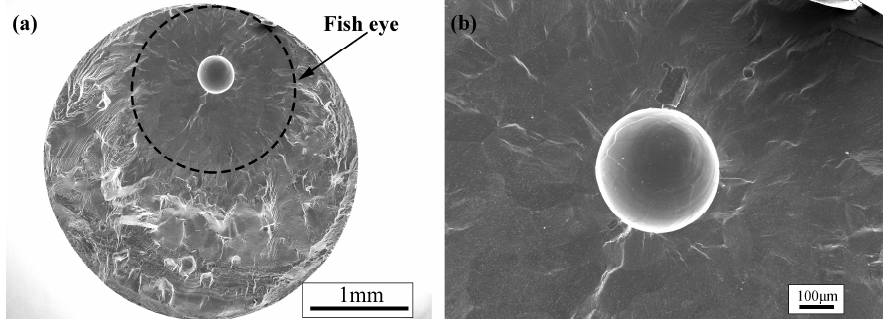
Figure 9. Micrographs of the bigger pore fatigue fracture of TC17 titanium alloy welded joint, ( a ) overall shape of the welded joint fracture, ( b ) fatigue source area morphology of the internal pore of the welded joint ( σ a = 340 MPa,N f = 2.0606 × 10 6 ).